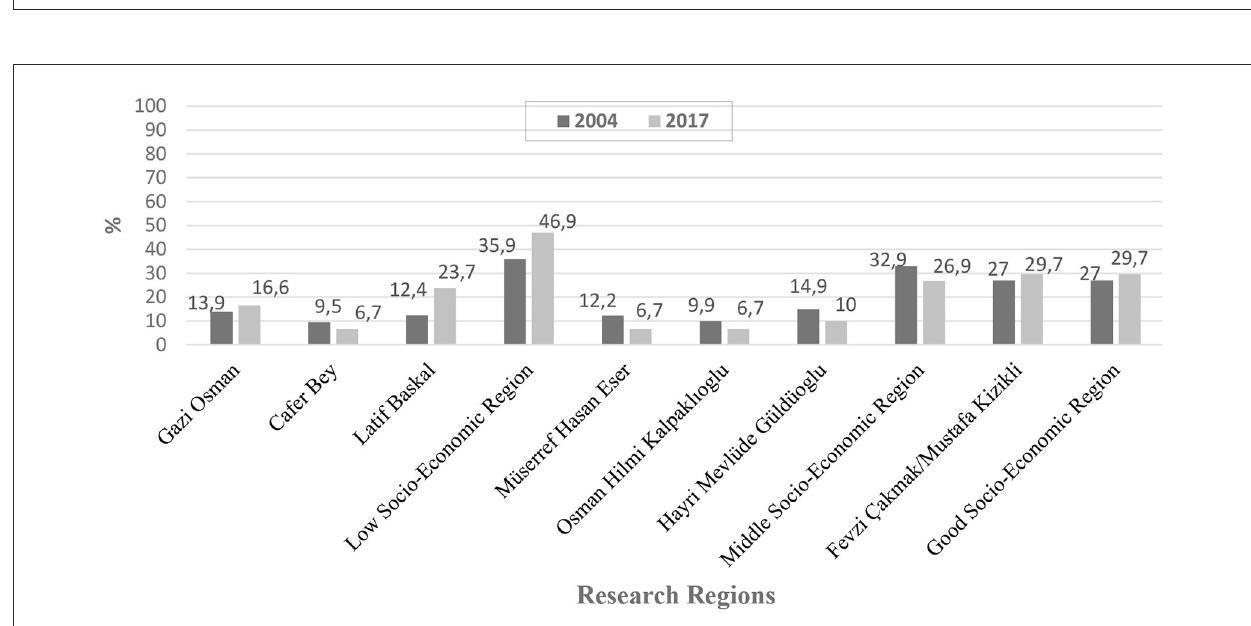
FIGURE2 Distribution of the number of people reached in 2004 and